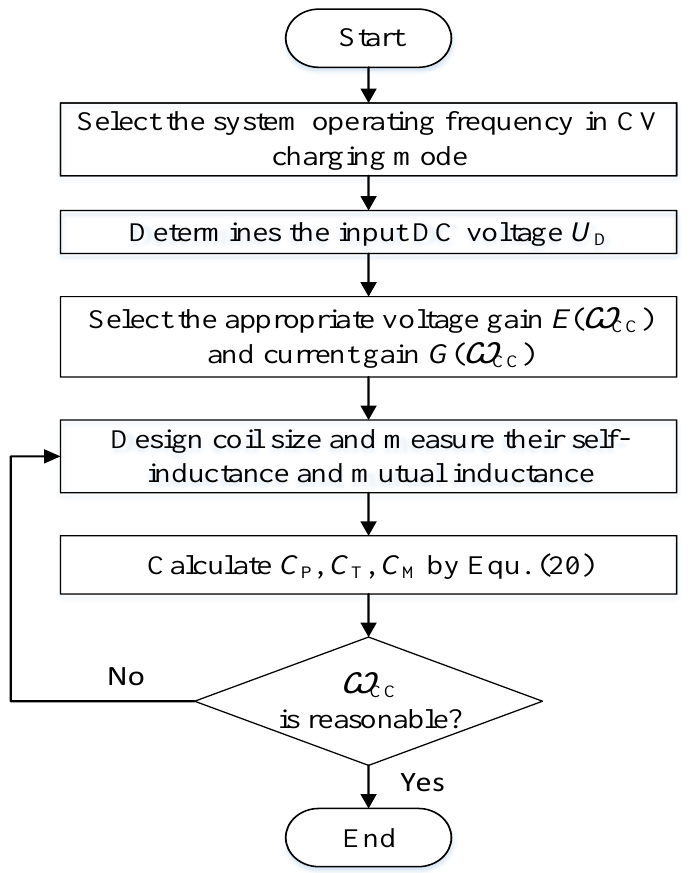
Figure 4. Design approaches of the S/PS − compensated WPT system.